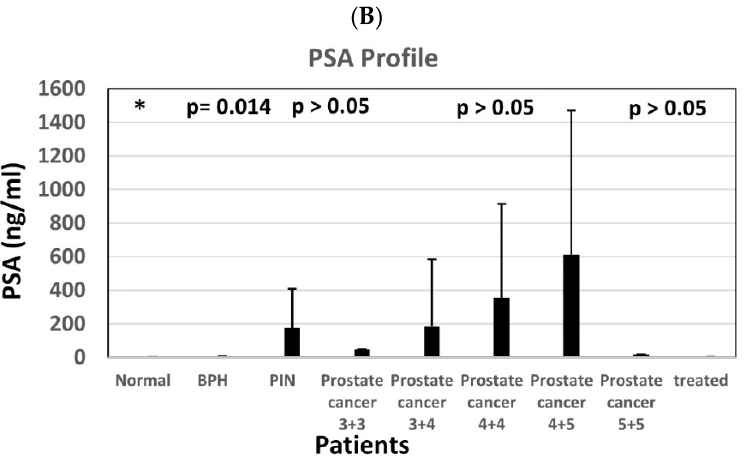
Figure 8. ( A ) PSA profile in patients, ( B ) PSA profile in patients with Gleason score, Serum PSA concentrations in various patients. ( A ) shows the average PSA concentrations with standard deviations in the serum samples from the treated prostate cancer patients, the patients with prostate cancer, the patients with premalignant PIN, or the patients with BPH in comparison to those from normal individuals. ( B ) shows that the average PSA concentrations with standard deviations in the serum samples from the treated prostate cancer patients, prostate cancer patients with different Gleason score, and patients with prostate premalignant PIN, or BPH, compared to those from normal individuals. The number on top of each bar was the p value when the data were compared to the normal after statistical analysis, as described in “Materials and Methods”.